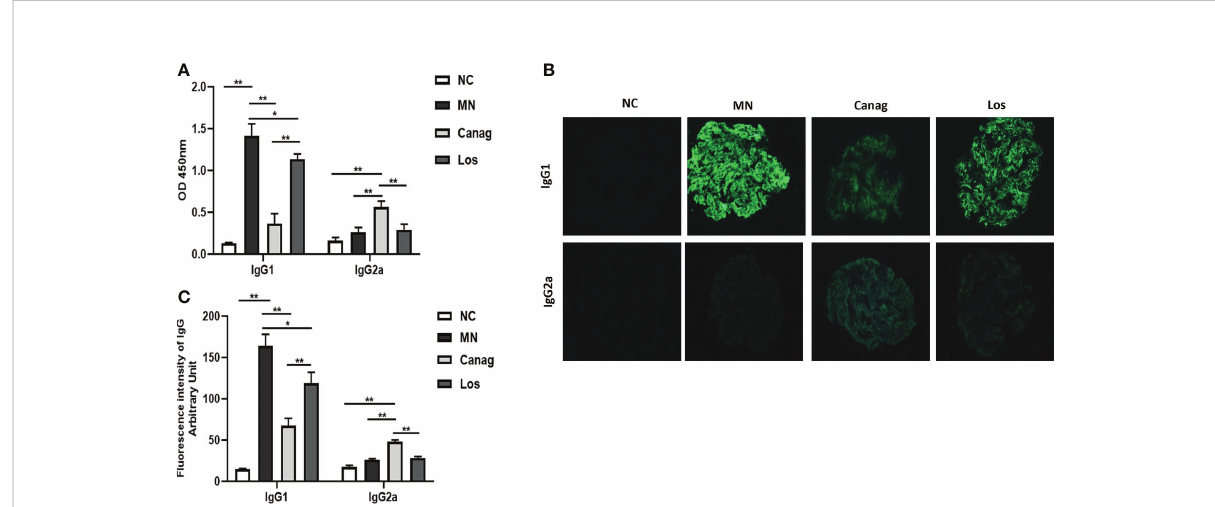
FIGURE 4 Canagli fl ozin decreases the secretion of IgG1 from B lymphocytes of MN rats. (A) Concentrations of IgG1 and IgG2a in the supernatant of B- cells were detected by ELISA. (B) Representative immuno fl uorescence images of IgG1 and IgG2a in glomeruli. (C) The quantitative fl uorescence intensity of IgG1 and IgG2a. Data are shown as mean ± SEM values. One-way ANOVA followed by Tukey ’ s test for multiple comparisons was used. *P < 0.05, **P <